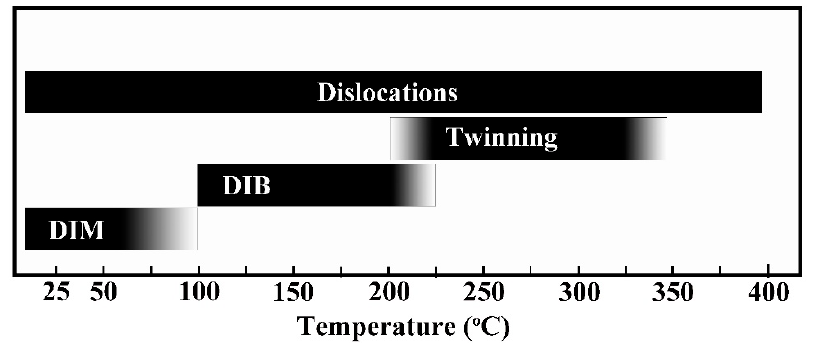
Figure 18. The deformation mechanisms at different temperature range. The black color gradient represents qualitatively the decrease of the intensity of the deformation mechanism.